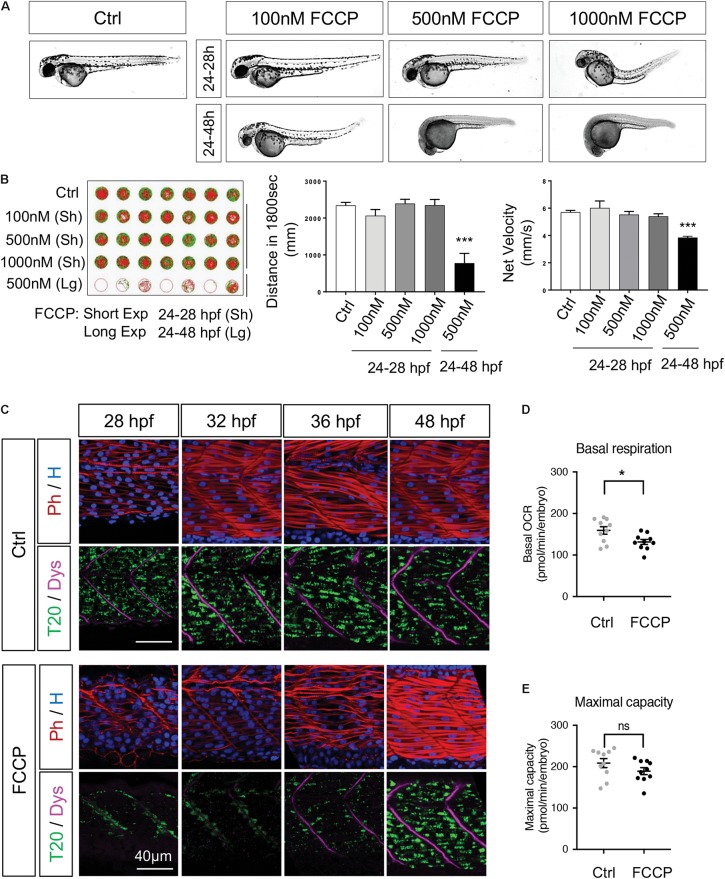
Mitochondrial quality is indispensable for embryogenesis. (A) Live embryos at 48 hpf after administration of FCCP with different doses and exposure durations. (B) Spontaneous locomotion in 5 dpf larvae after FCCP with different doses and durations. Slow velocity green lines are speeds between 3 and 6 mm/s. Fast velocity red lines are speeds > 6 mm/s (n = 12 fish per group). (C) Confocal imaging of mitochondrial network (Tomm20, T20; green) counterstained with Phalloidin (Ph; red), Dystrophin (Dys; magenta) and Hoescht (H; blue) with or without FCCP administration (500 nM from 24 to 28 hpf). (D,E) Basal respiration (D) and maximal respiration (E) in 48 hpf embryos with or without FCCP administration (500 nM from 24 to 28 hpf, n = 10 fish per group). Quantitative data are mean ± SEM. ∗P < 0.05, ∗∗∗P < 0.0001, unpaired T-test compared to control embryos (Ctrl). See also Supplementary Figure S8 and Supplementary Videos S2, S3.